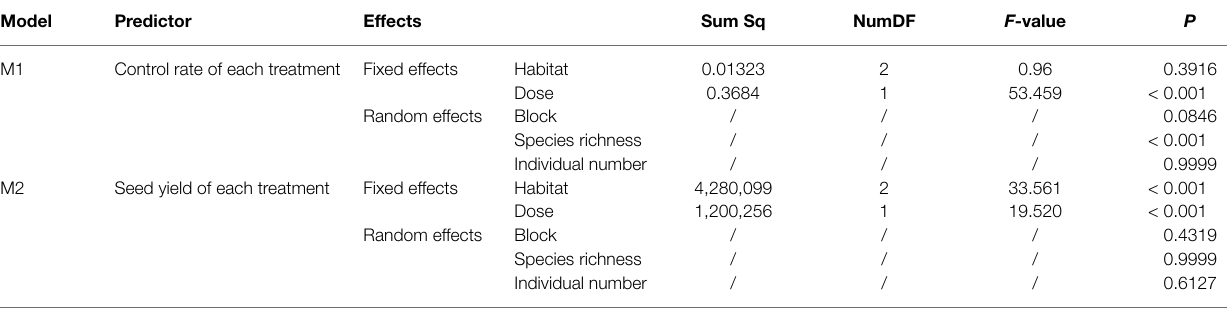
TABLE 4 | Linear mixed models were used to analyze the influence of each factor on A. artemisiifolia fitness. Model